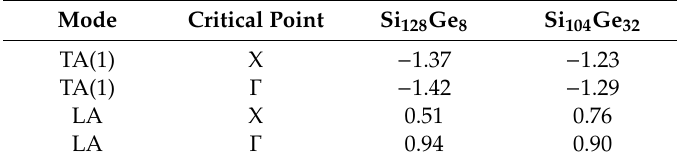
Table 1. Calculations of the mode Grüneisen parameters for the theoretically studied Si 136- x Ge x ( x = 8, 32).